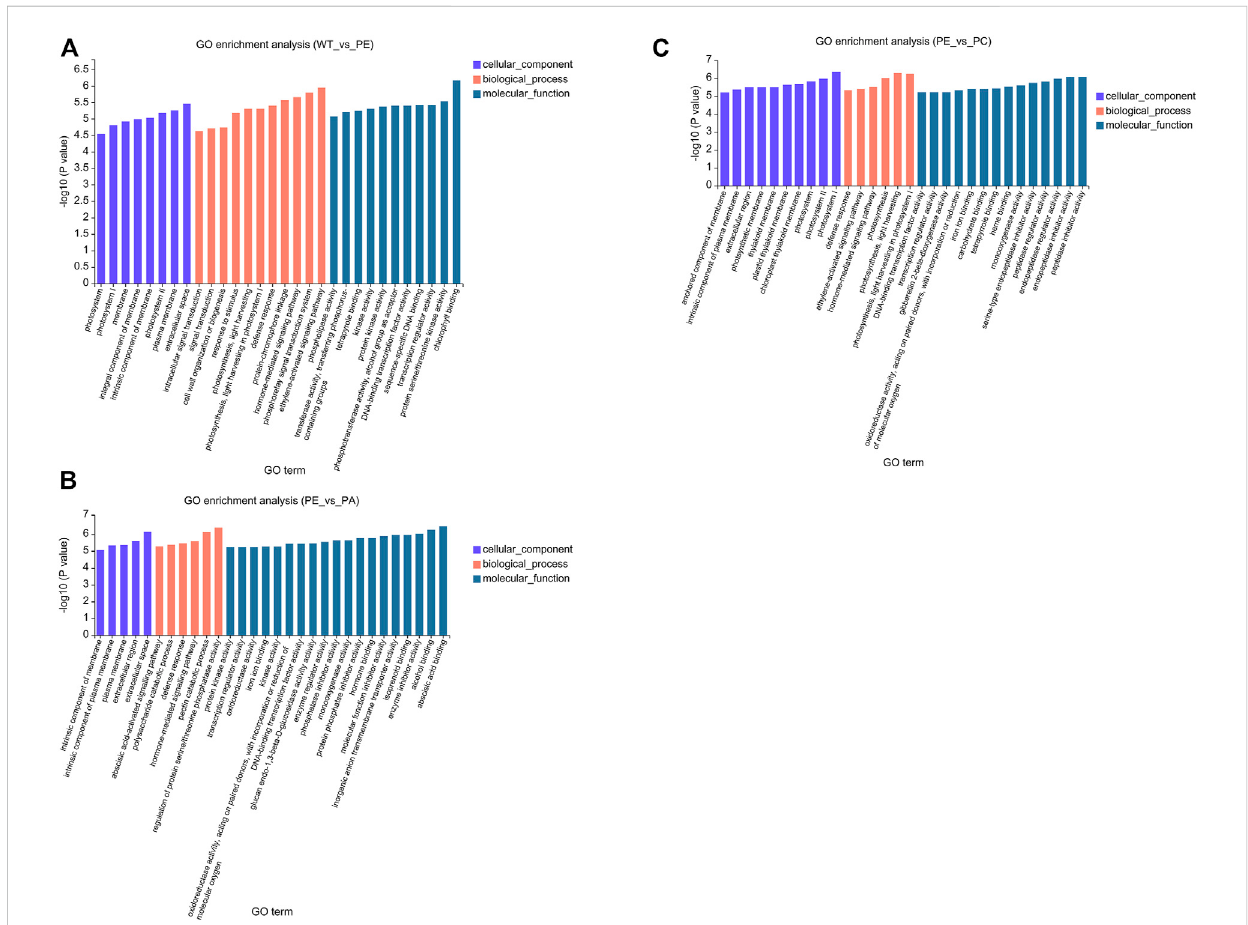
FIGURE 4 Gene Ontology (GO) functional enrichment of the DEGs. GO enrichment bar graphs of (A) WT_vs._PE, (B) PE_vs._PA, and (C) PE_vs._PC comparison groups. The abscissa represents the GO term, and the ordinate represents the signi fi cance of the enrichment, which corresponds to the height of the column. The larger the -log10 ( p -value) value, the more signi fi cantly enriched the GO